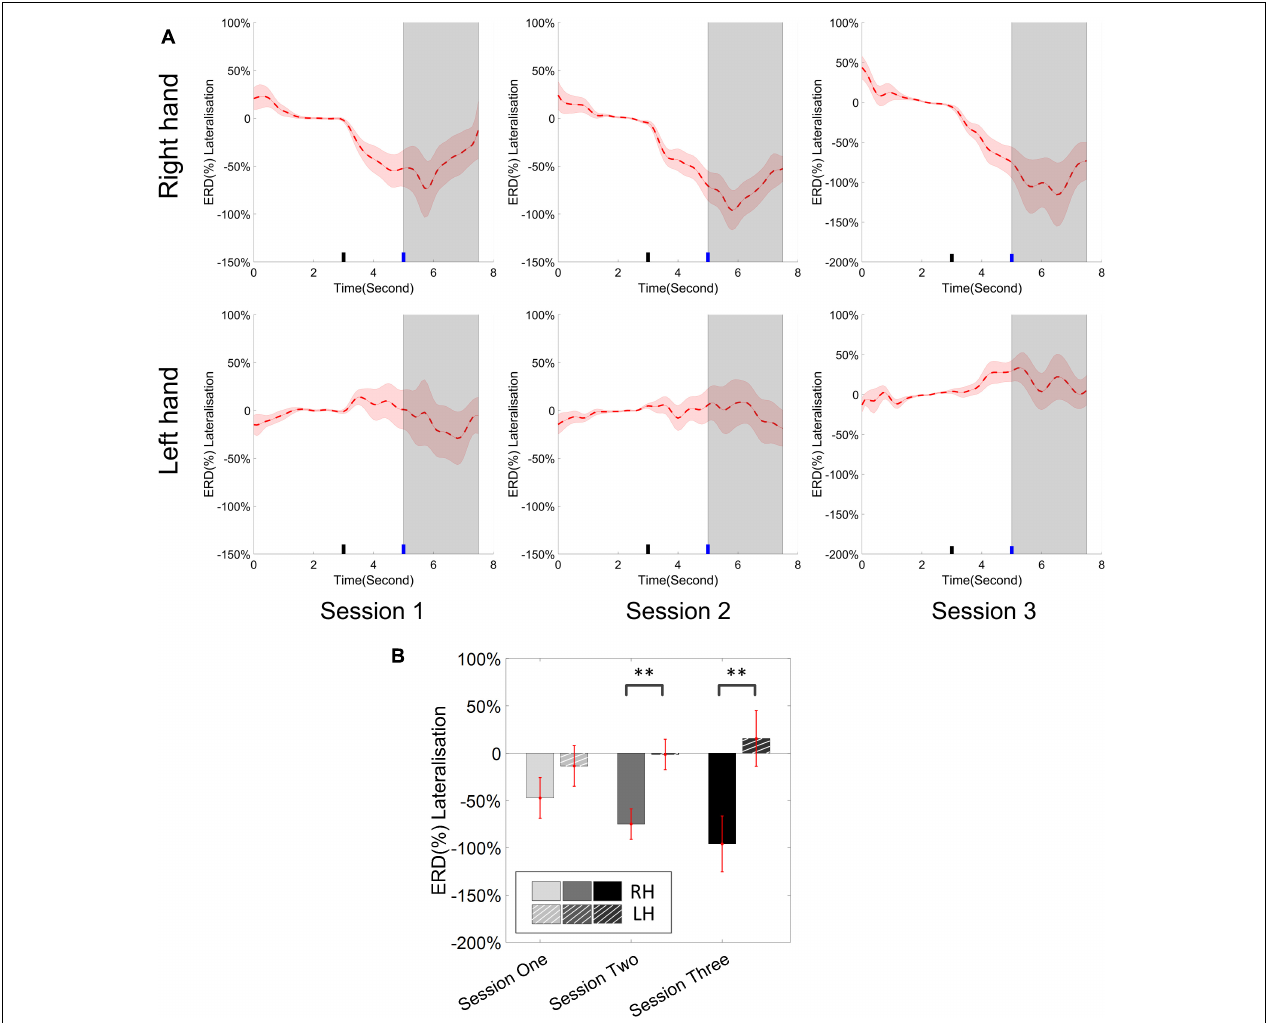
FIGURE 8 | (A) Group average ERD% lateralization (difference between contra- and ipsilateral ERD%, calculated from all the trials) with respect to the hand task, across the three training sessions. The shaded red areas represented the standard error of the mean. The target cue appeared at the end of second 3 and the cursor feedback began at the end of second 5. (B) The grand average ERD% lateralization values during the period of [5–7.5]s, which was marked in gray area in subplot (A) . Error bars represented the standard error of the mean. ∗∗ p <